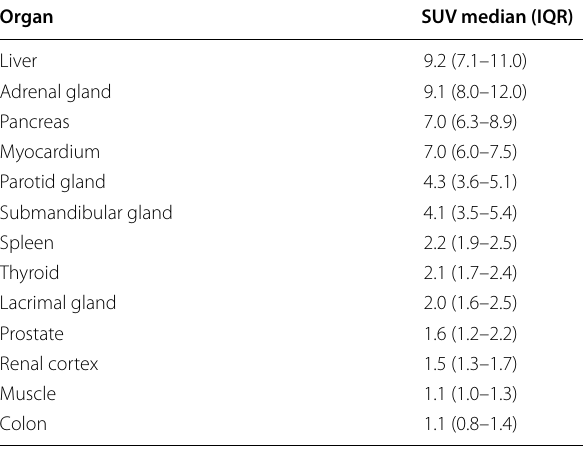
5: Table 1A B. Overview of best-fit-models in differ- + ent organs is presented in Additional file 6: Table 2. We Table 2 SUV 50–70 min post injection for all organs